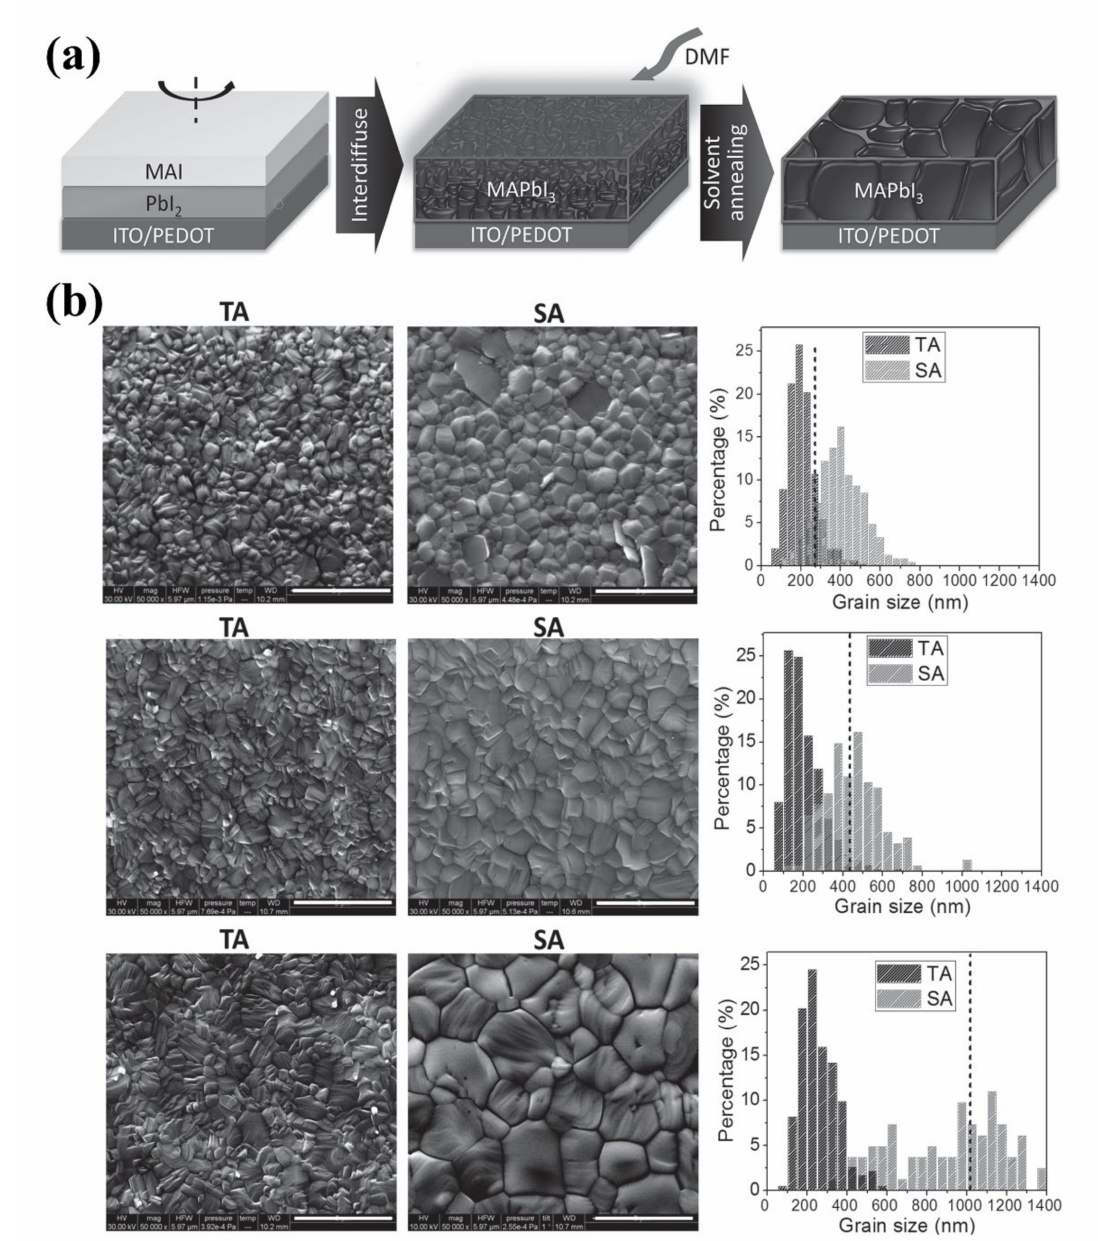
Figure 13. ( a ) Schematics of the inter-diffusion approach and solvent-annealing-induced grain size increase; ( b ) schematic diagram of DMF solvent annealing with SEM images at different thicknesses of thermal/solvent annealing. Reprinted with permission from Ref. [21]. Copyright 2014 Wiley-VCH GmbH,